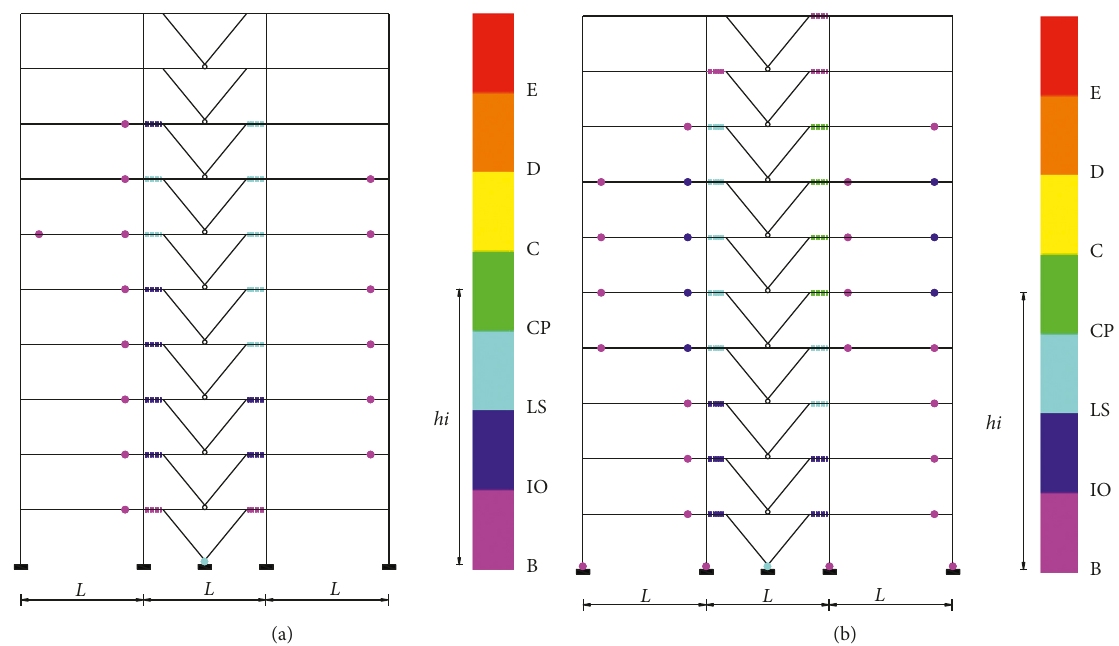
Figure 10: Inelastic activity of the 10-story V-EBF at a roof drift ratio of (a) 1.05% and (b) 2% ( : yielding in link and : plastic hinge).